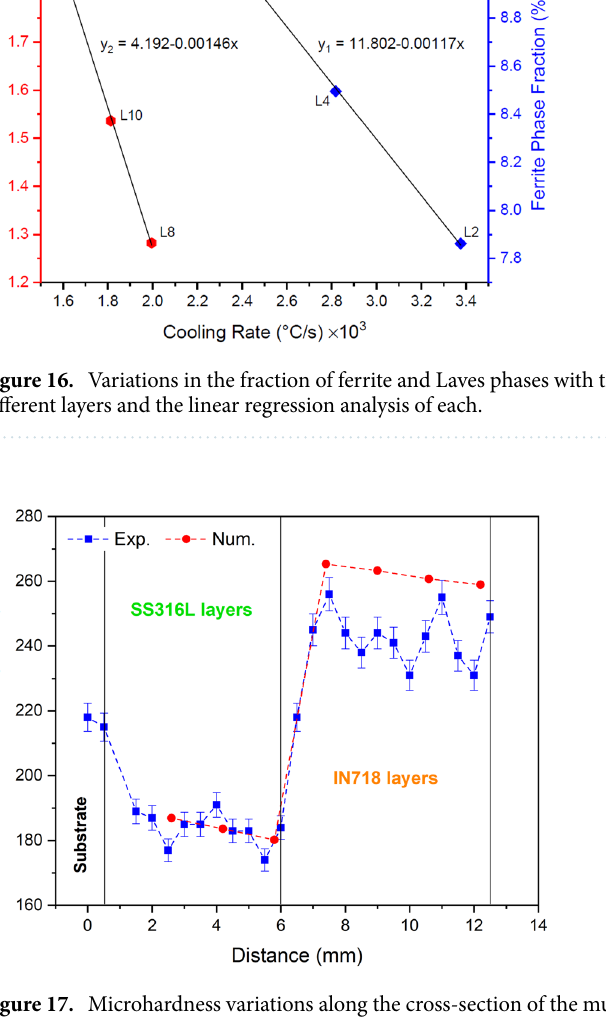
Figure 17. Microhardness variations along the cross-section of the multi-material